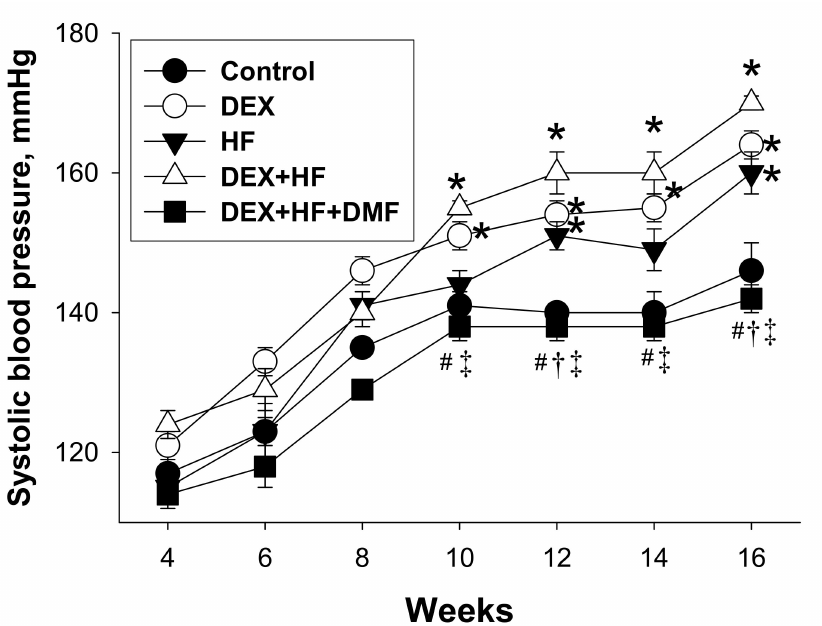
Figure 1. E ff ects of prenatal dexamethasone (DEX), postnatal high-fat diet (HF), and dimethyl fumarate (DMF) on systolic blood pressure in male o ff spring. * p < 0.05 vs. control; # p < 0.05 vs. DEX; † p <